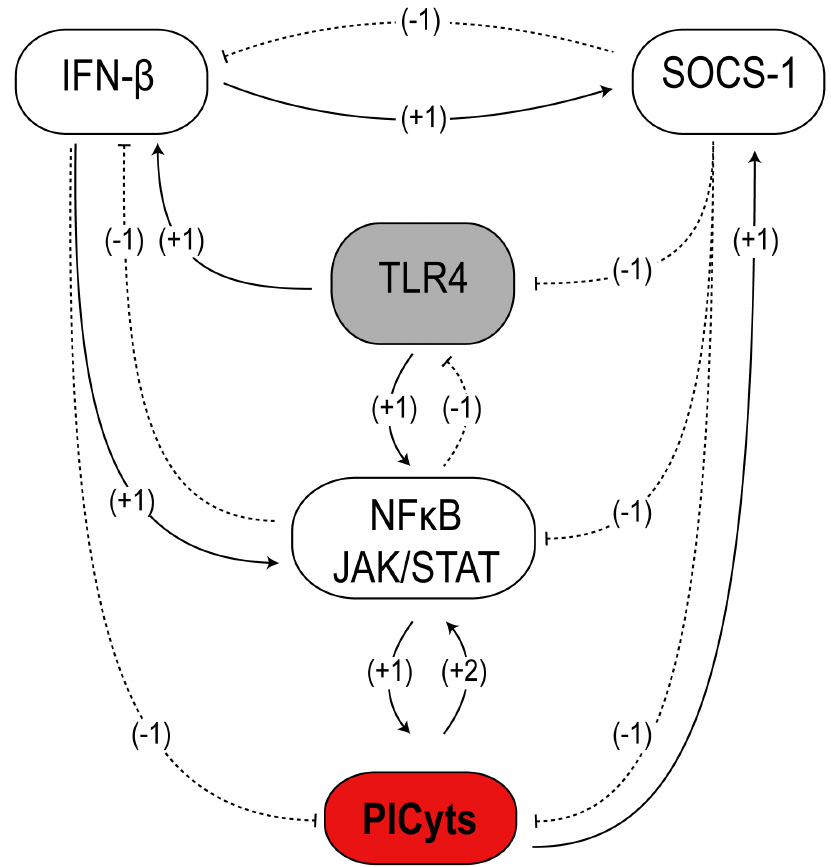
Figure 2. The BRN of TLR4 and JAK/STAT signalling pathway. The reduced BRN of TLR4 and JAK/STAT signalling pathway is derived from Figure 1. Nodes represent entities, whereas interactions between them are shown as edges. Sign on the edges represent the type of interaction between nodes i.e. positive for activation (solid arrows) and negative for inhibition (dotted arrows). Integers ‘‘1’’ and ‘‘2’’ on the edges represent the threshold levels of entities (see Material and Methods